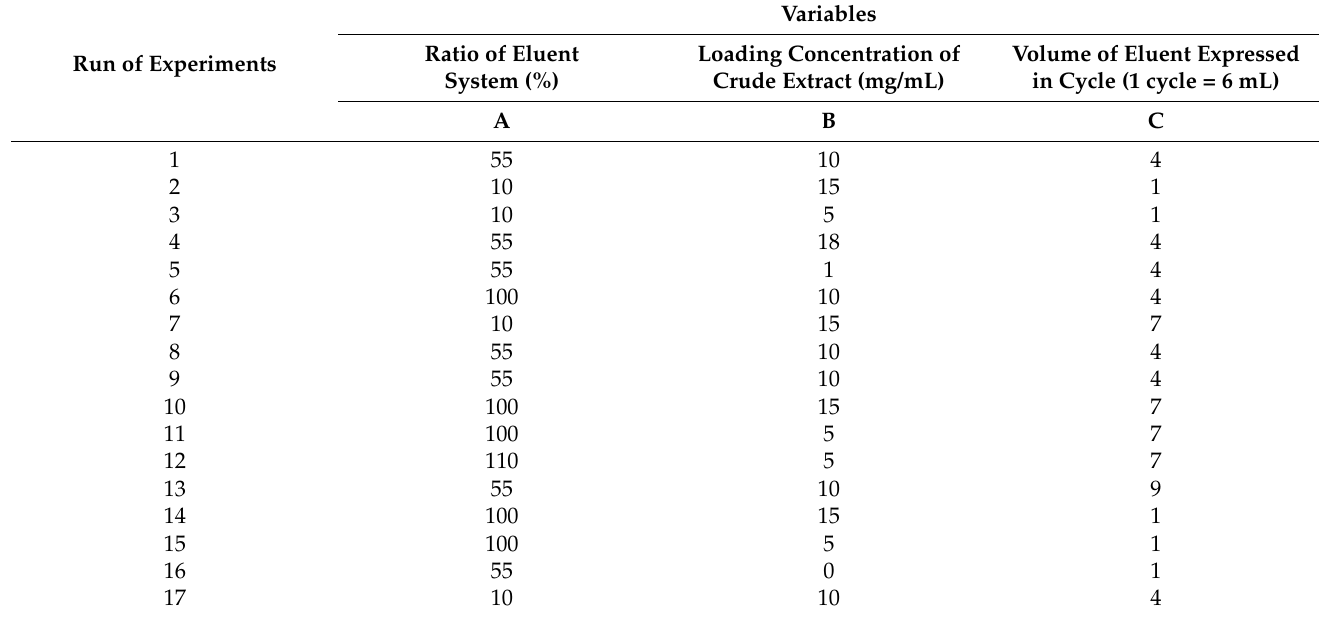
Table 1. Central composite design for 17 experiments performed at different ratios of eluent system, loading concentrations of crude extract, and numbers of cycles to fractionate plant crude extract. Variables Ratio of Eluent Loading Concentration of Volume of Eluent Run of Experiments System (%) Crude Extract (mg/mL)